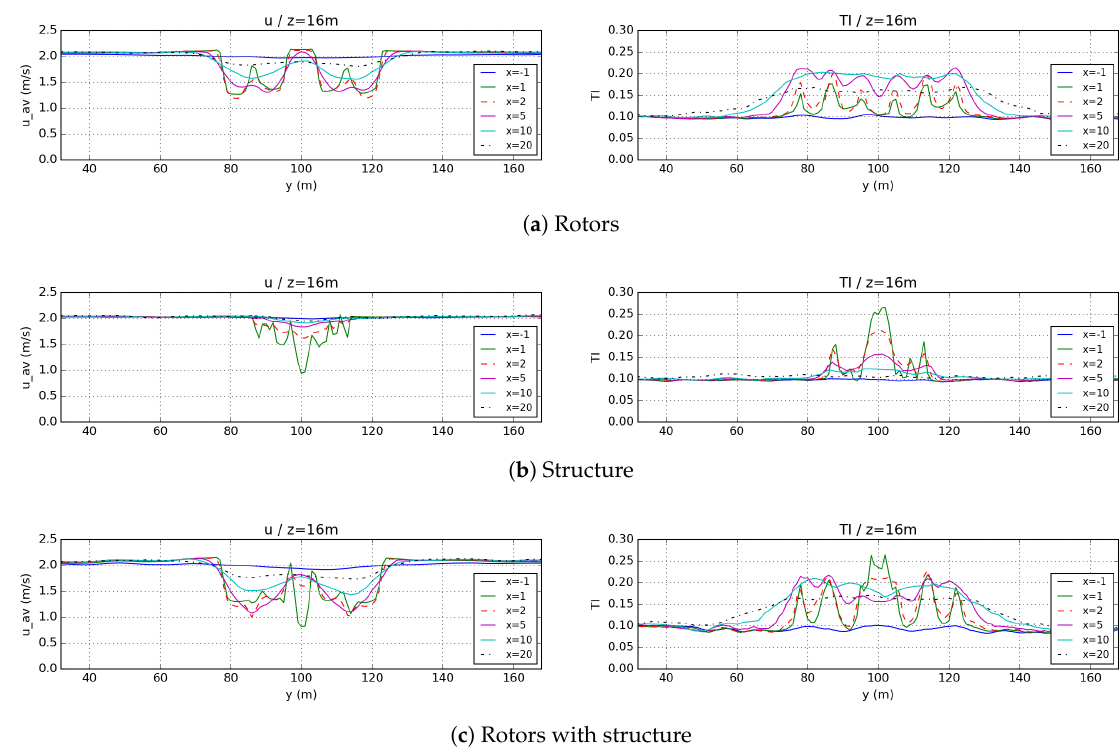
Figure 14. Horizontal transects of time-averaged velocity and turbulence intensity at z = 16 m for each full-scale case. Units for x are